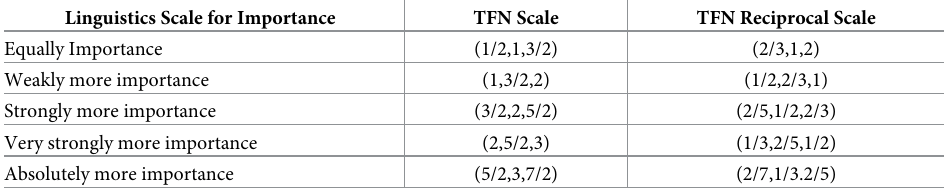
Table 10. TFN scale for a pairwise comparison using FAHP